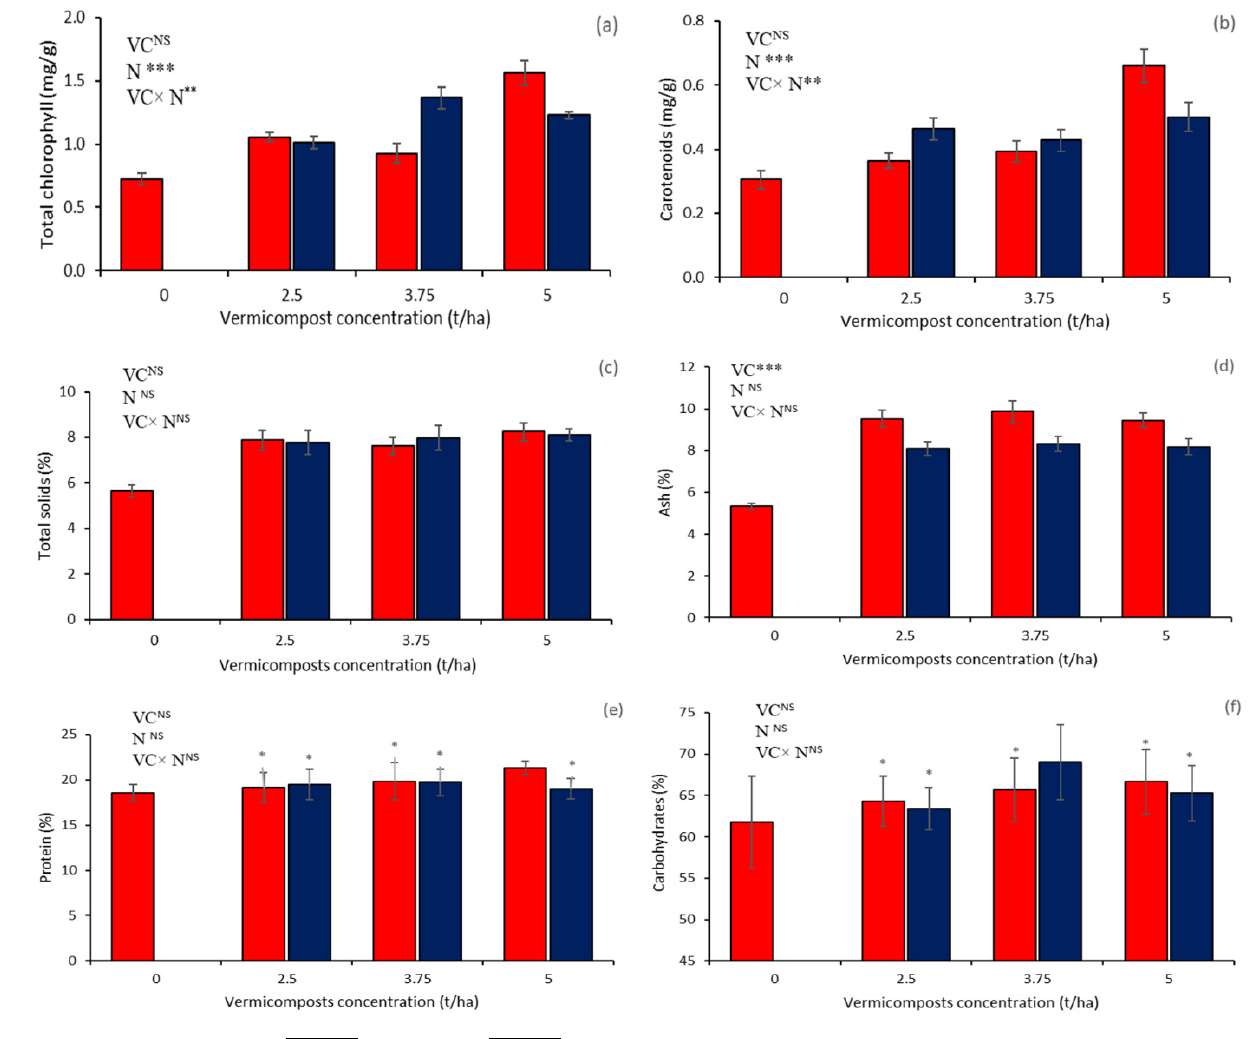
Figure 2. Effect of LVC and CDVC on ladies fingerin terms of ( a ) total chlorophyll in the leaves; ( b ) carotenoids in the leaves; ( c ) total solids; ( d ) ash; ( e ) protein in pods; and ( f ) carbohydrates in pods. All the bars carry range of standard deviation. Bars topped with an asterisk indicate that the corresponding numbers do not differ significantly from the controls at p ≤ 0.05. N indicate the vermicompost treatments.